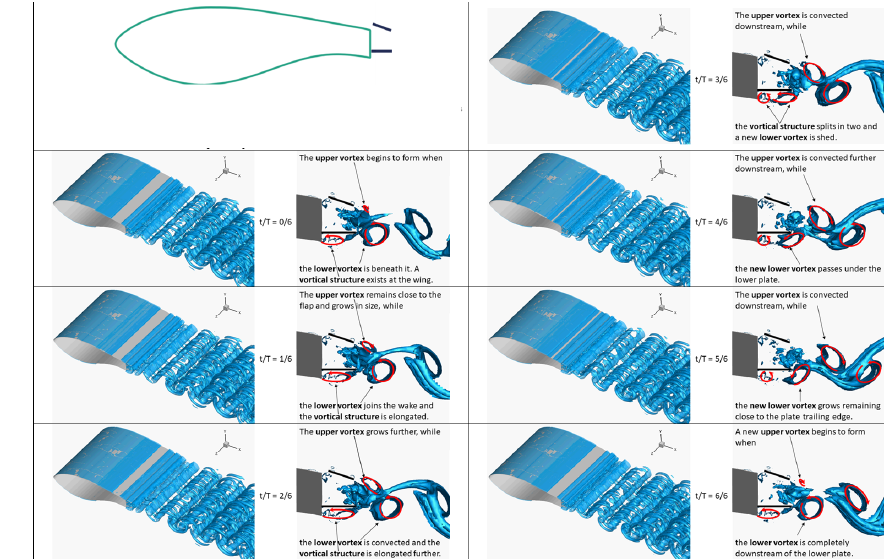
Figure A4. Snapshots of Q isosurfaces from the flap + offset case: IDDES fine-mesh results. Each period of the vortex shedding mechanism is split into six parts, and a total of seven snapshots is shown. For each snapshot, two visualisations are shown. A 3D view of Q = 1 . 5 isosurfaces is shown on the left, and a side view of Q = 100 isosurfaces is shown on the right. Superimposed red arrows indicate interpreted spanwise